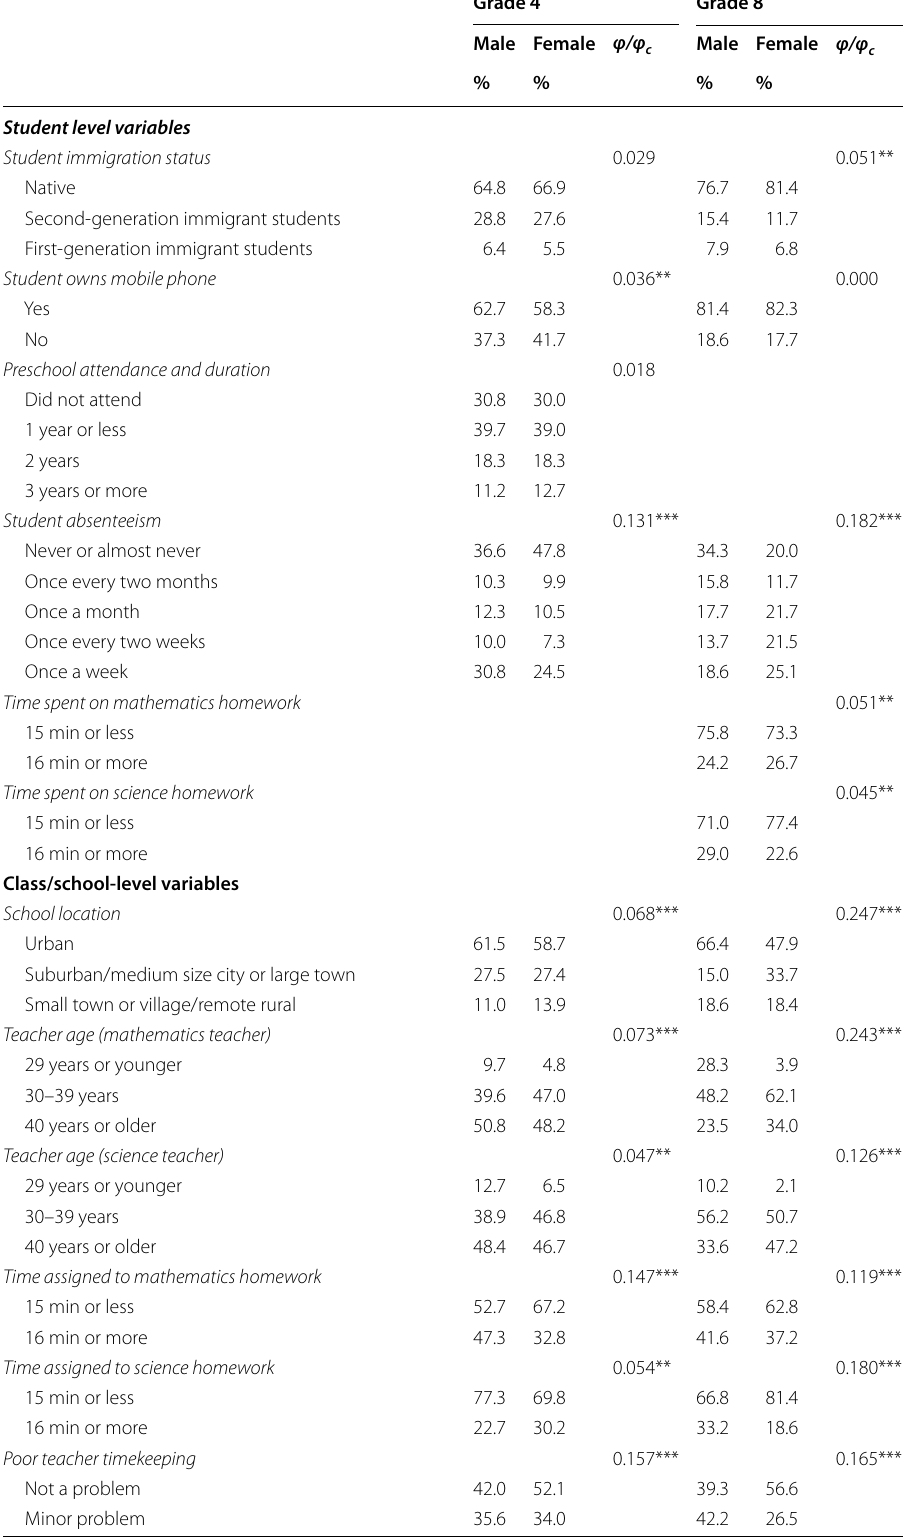
Table 3 Contextual categorical variables by gender, TIMSS